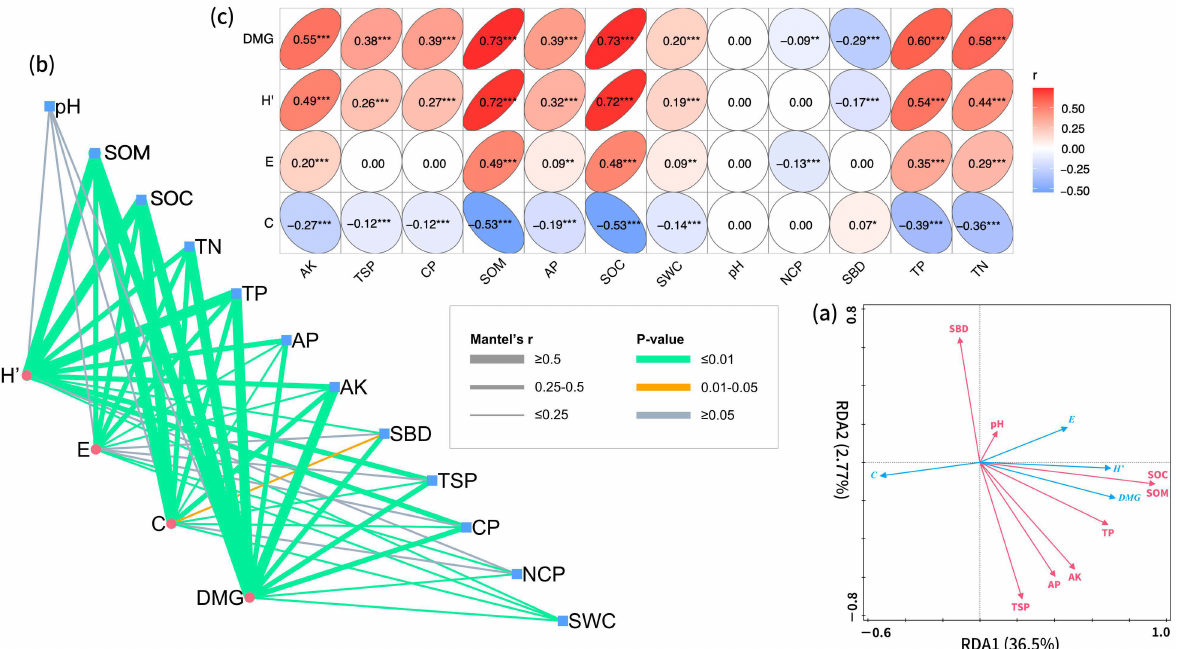
Figure 7. Plant community diversity index (spring and summer) and RDA ordination map of soil environmental factors. ( a ) Redundancy analysis (RDA) on soil factors and understory plant diversity; ( b ) correlation between diversity index of understory plants and soil factors in spring and summer; ( c ) correlation coefficient between understory plant diversity index and soil factors in spring and summer. Note: * correlation significant at 0.01–0.05 level. ** correlation significant at 0.01–0.001 level. *** correlation significant at <0.001